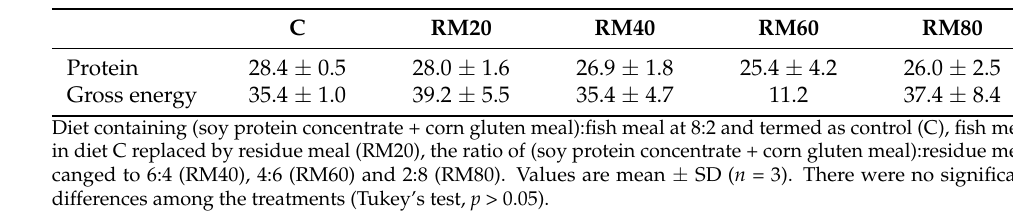
Table 8. Retention efficiency of protein and gross energy in Trial